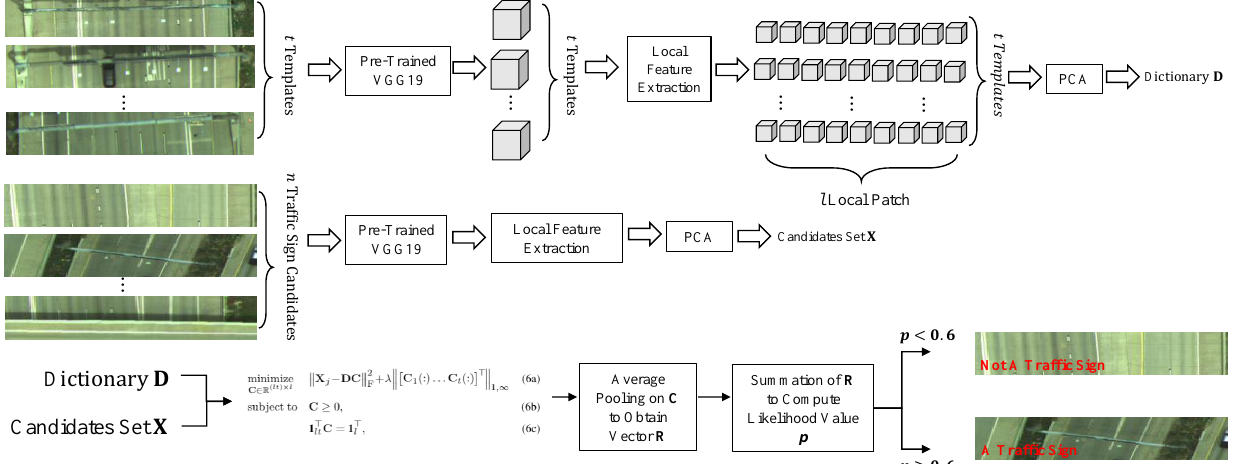
Figure 2. The overview of the proposed deep-features-based sparse classifier optimization